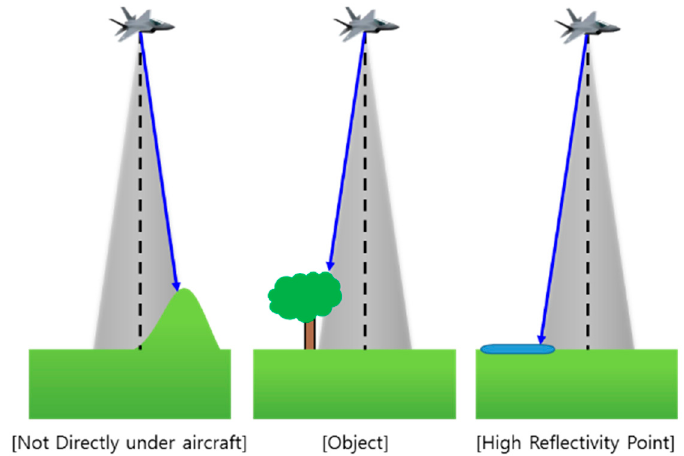
Figure 3. Error examples of RA [12].